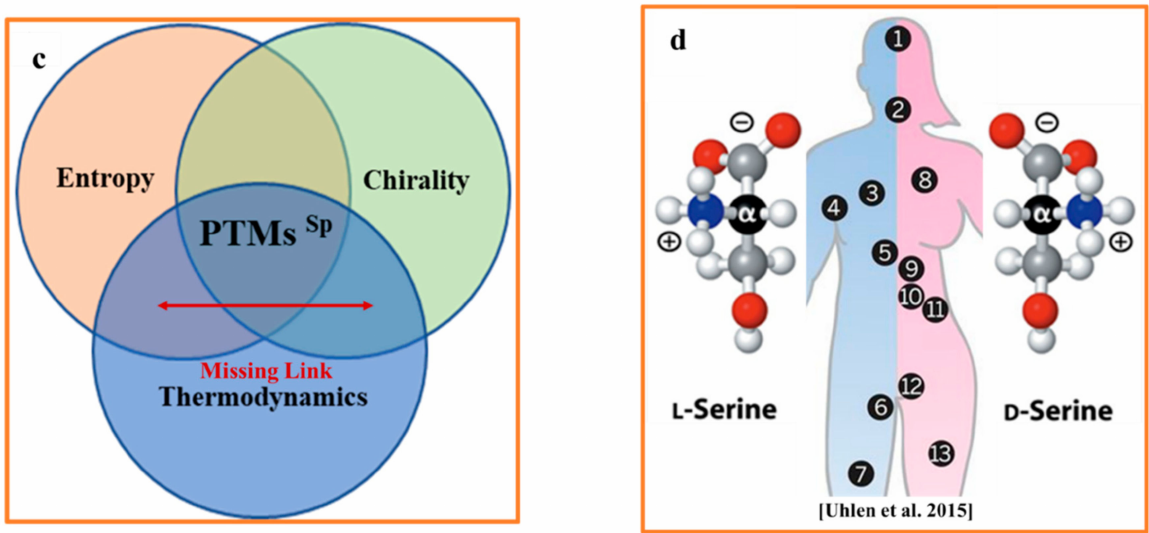
Figure 1. ( a ) In a hydrogen atom, aligning the spins of the proton (blue) and the electron (red) increases the atom’s total spin from zero to one. Antiparallel electron and proton spin alignments ( left ), the system occurs in a lower energy state. Parallel electron and proton spins configuration ( right ) has slightly higher energy state. Adapted from [6]. ( b ) Carbon atom has four equivalent half-filled sp3 hybrid orbitals at the ground state, which form a chirogenic tetrahedron. ( c ) Three major determinants of spontaneous racemization in the non-equilibrium bio-molecular system: thermodynamics, entropy, and chirality. ( d ) The regions of human body containing trackable levels of D-AAs. 1. Brain. 2. Endocrine tissue. 3. Lung. 4. Blood and immune system. 5. Liver. 6. Male Tissue. 7. Adipose tissue. 8. Heart and skeletal muscle. 9. Gastrointestinal tract. 10. Pancreas. 11. Kidney. 12. Female tissue. 13.